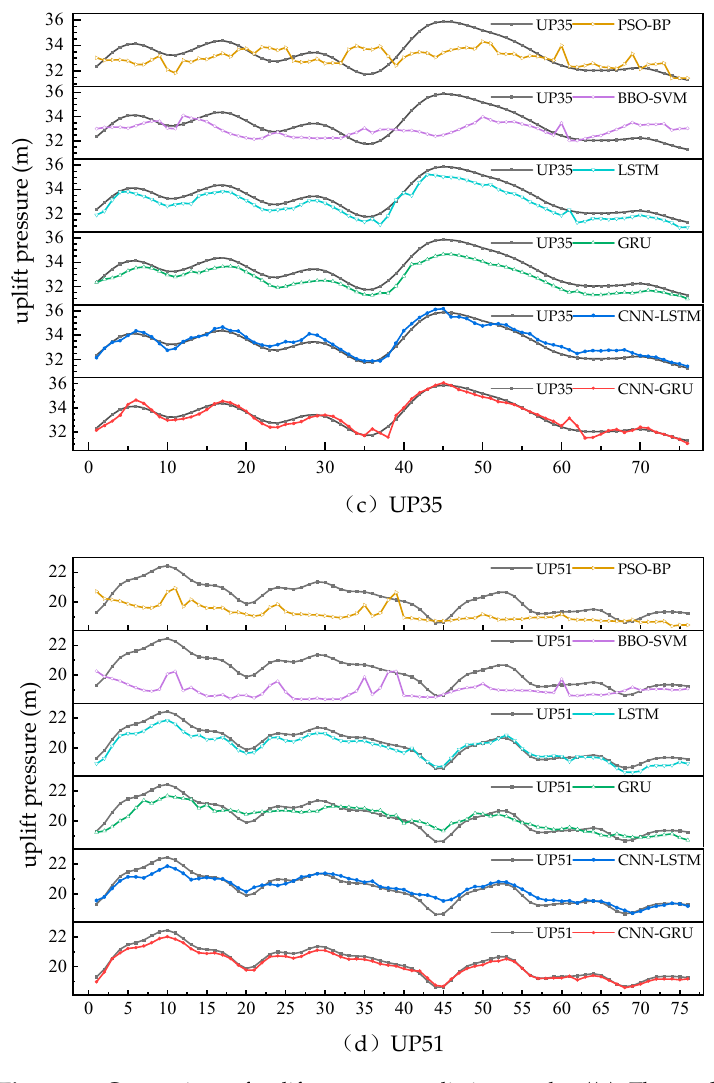
Figure 11. Comparison of uplift pressure prediction results. (( a ): The prediction results of each model on the uplift pressure data of the UP17 measuring point; ( b ): The prediction results of each model on the uplift pressure data of the UP26 measuring point; ( c ): The prediction results of each model on the uplift pressure data of the UP35 measuring point; ( d ): The prediction results of each model on the uplift pressure data of the UP51 measuring point.) Table 6. The value of each evaluation index.